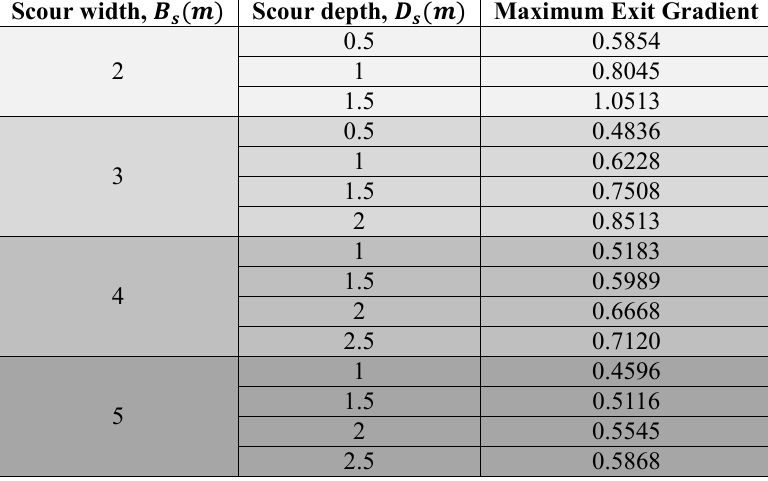
Table 5. Maximum Exit Gradient for different scour